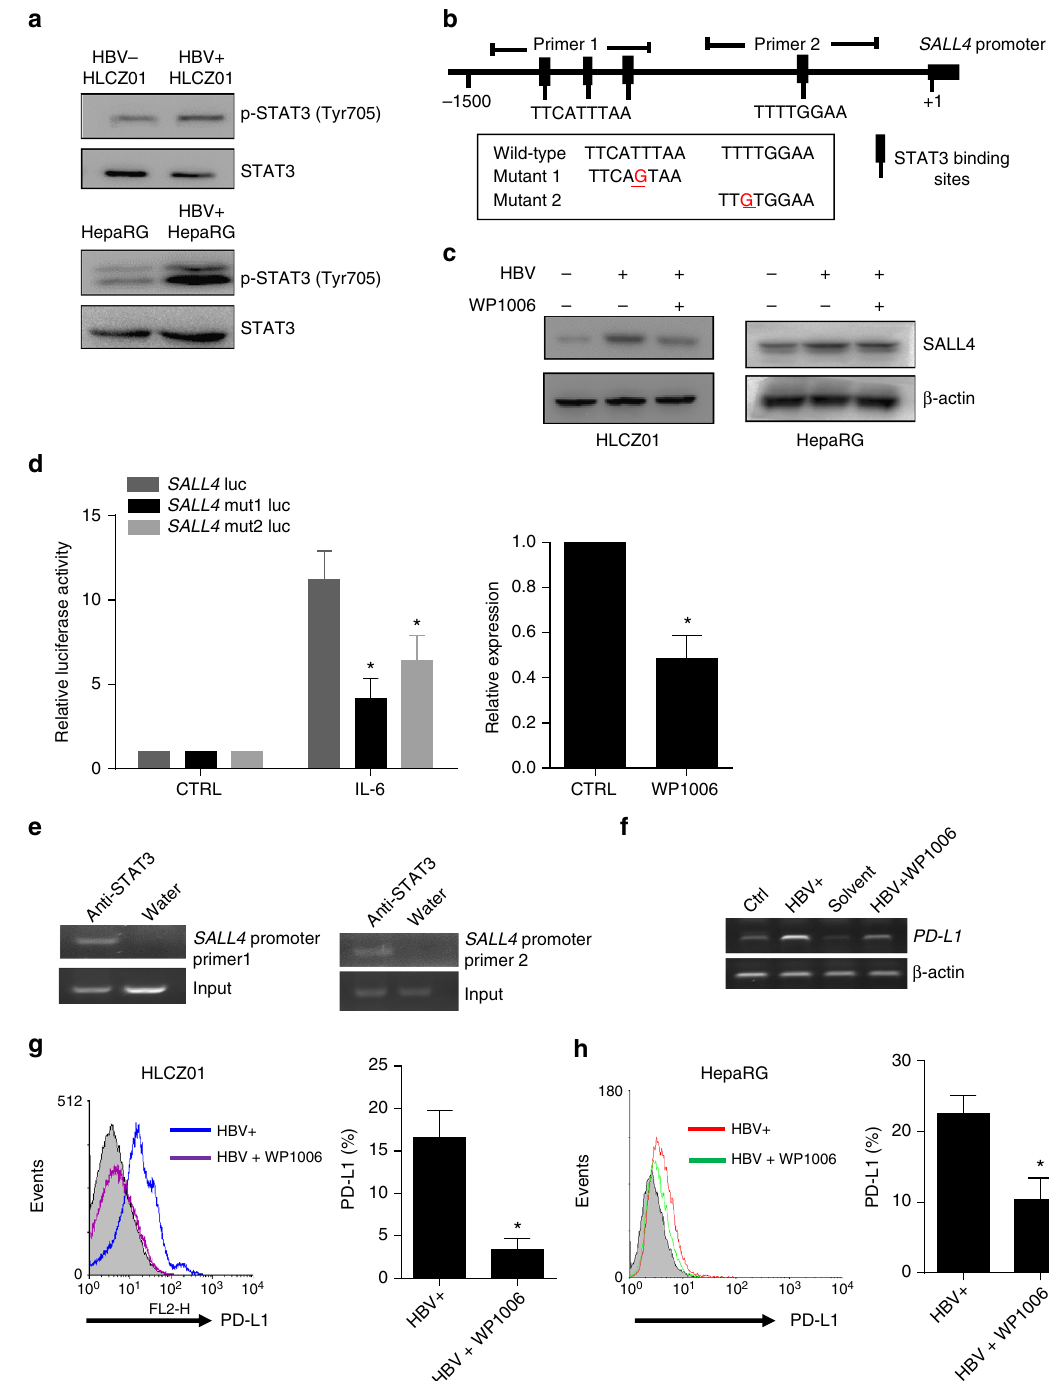
Fig. 6 HBV triggers SALL4 expression via STAT3 activation. a STAT3 activation was assayed in HBV - and HBV + Hepatoma cells. HBV-infected